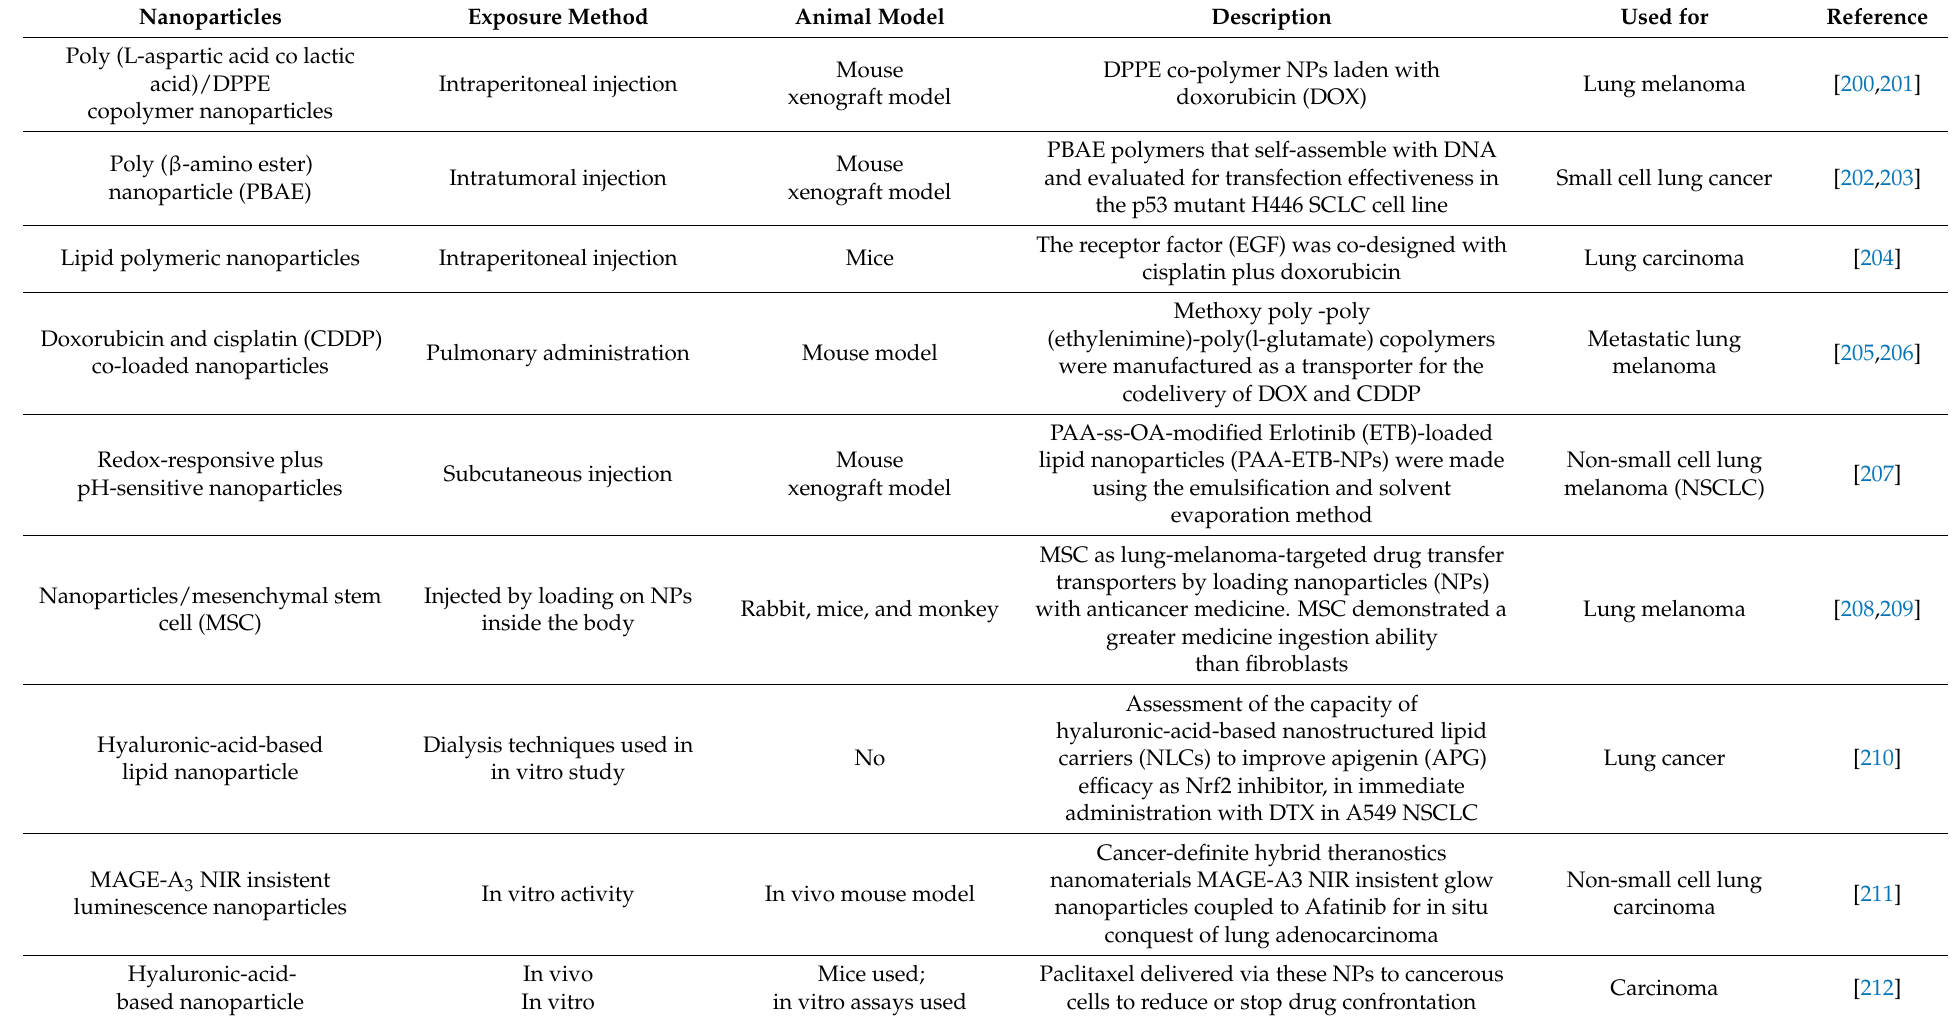
Table 5. Recent discovered nanoparticle’s role in lung cancer